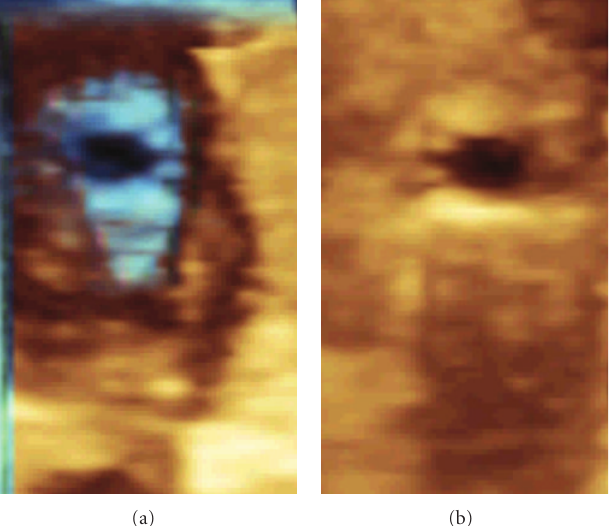
Figure 7: Real time 3D internal (a) and external (b) echocardiographic views of the left ventricular free wall rupture, which has a circular